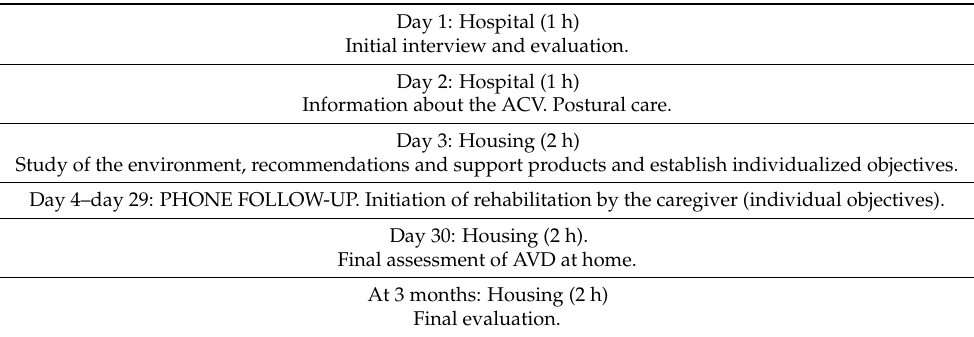
Table 3. Temporary